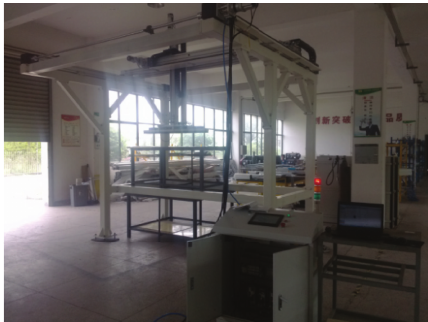
Figure 2: Experimental device of the glass-handing robot.